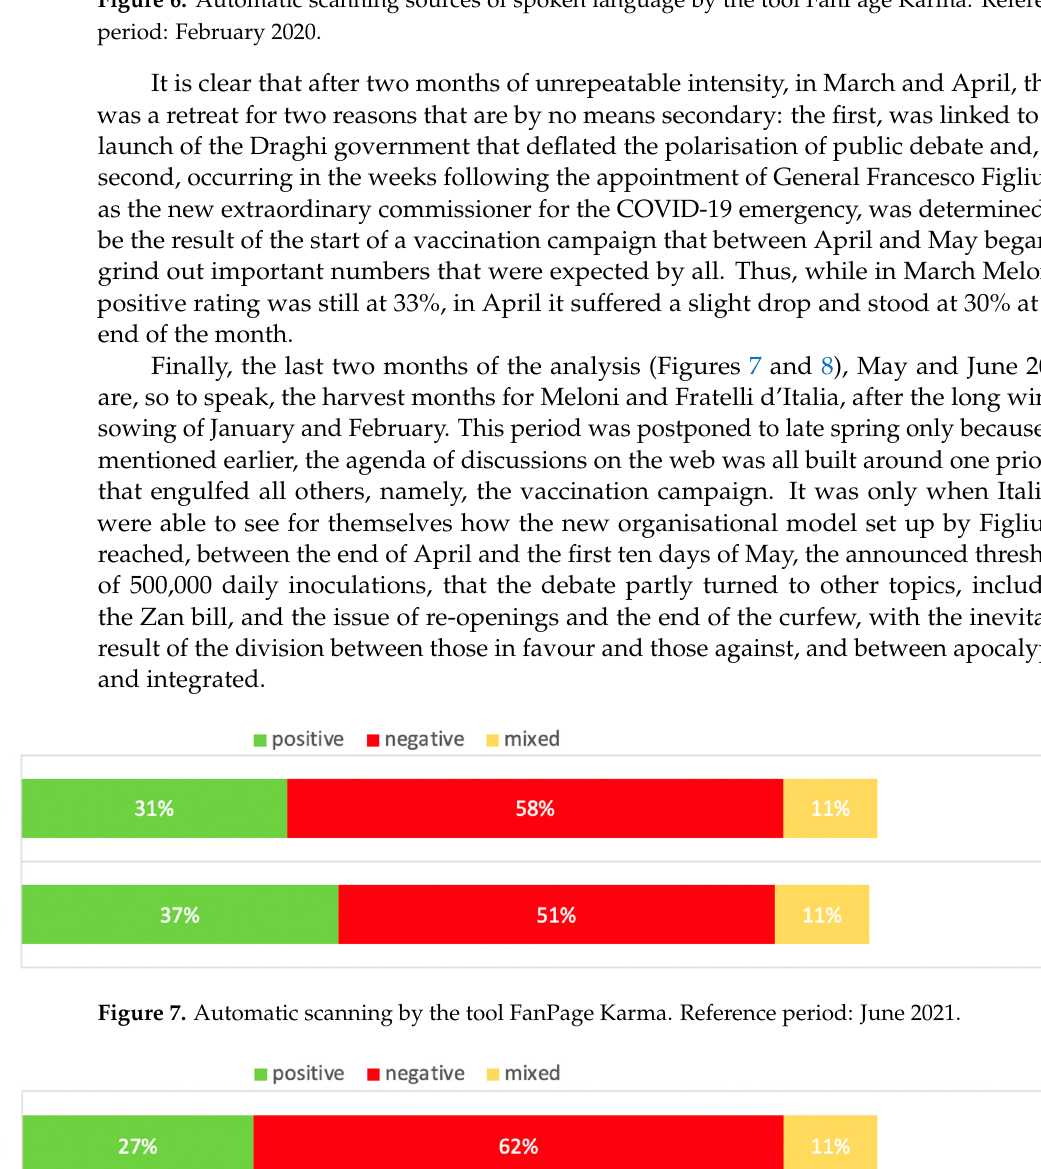
Figure 6. Automatic scanning sources of spoken language by the tool FanPage Karma. Reference